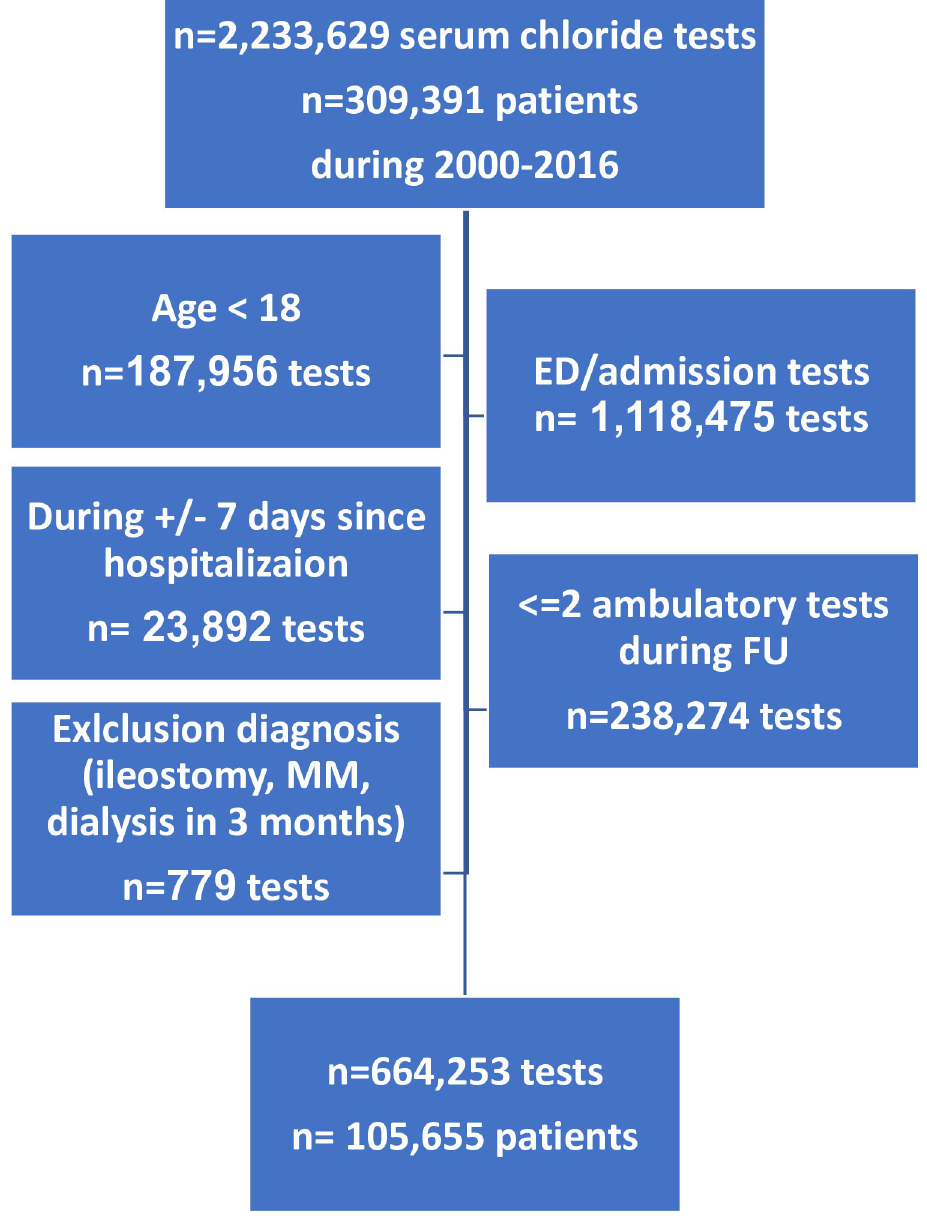
Fig 1. p < 0.001). In contrast, in patients with malignancy chloride depletion was less common (8.3% vs.5.3% p < 0.001. Outcome During a median follow up duration of 10.5 years, 11,694 subjects out of 105,655 died (Kaplan Meier rate of 11%). In Cox proportional hazards multivariate analysis, hypochloremia ( � 97 mmol/L) was an independent strong predictive factor for all-cause mortality. Both depletion